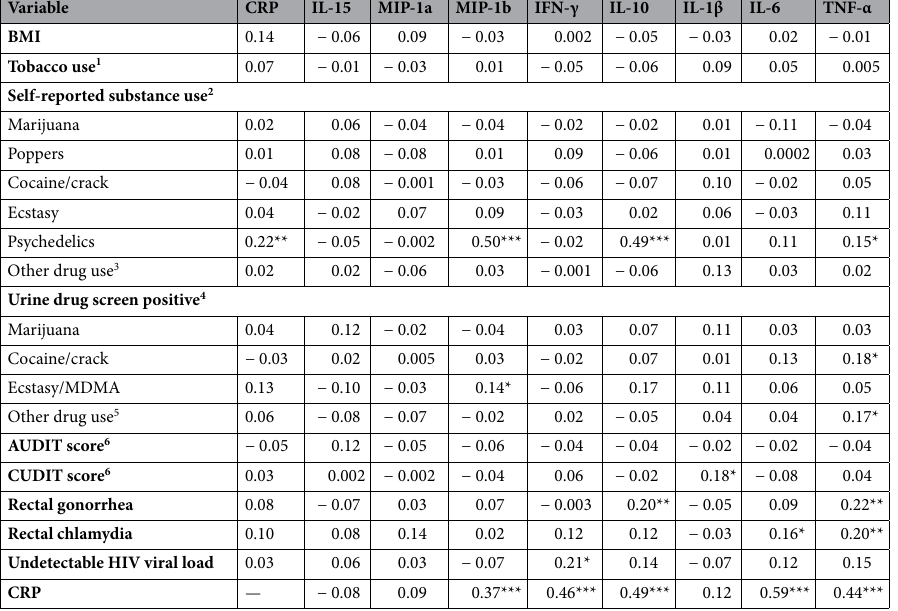
Table 3 depicts the correlation between different biomarkers of inflammation and the use of various substances among HIV-negative participants. C-reactive protein was significantly correlated with IL-15 (r = 0.16; p = 0.003) MIP-1b (r = 0.10, p = 0.022), IFN-γ (r = 0.27, p < 0.001), IL-10 (r = 0.16, p < 0.001), IL-6 (r = 0.50, p < 0.001), and TNF-α (r = 0.20, p < 0.001). Self-reported marijuana use was significantly correlated with CRP (r = − 0.13, p = 0.003), IFN-γ (r = -− 0.10, p = 0.030), and IL-6 (r = -− 0.13, p = 0.004); urine screen positive for marijuana use was correlated with IL-15